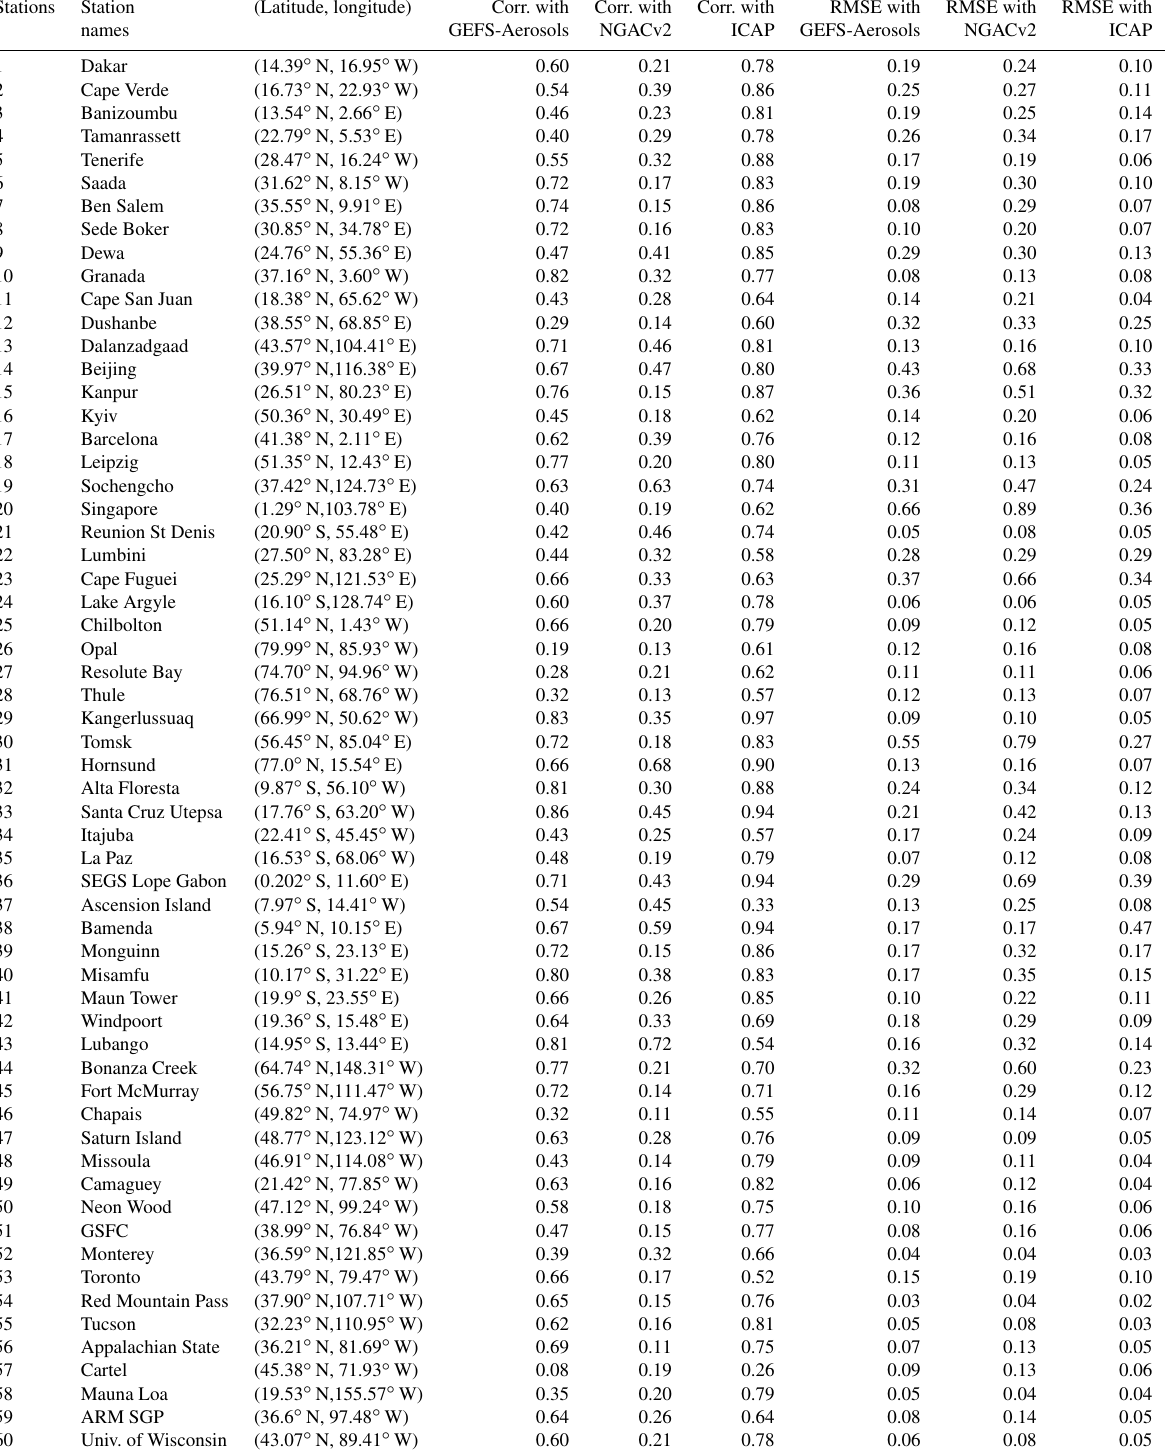
Table 1. AERONET site information, the correlation coefficients, and the root mean square error (RMSE) of GEFS-Aerosols, ICAP, and NGACv2 AOD with respect to that of AERONET observation for the period 5 July–30 November 2019. Correlation coefficients are at the 95% confidence